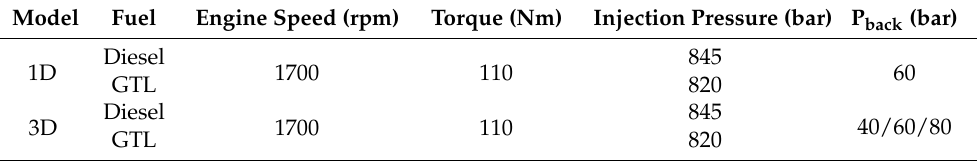
Table 3. Operating modes used in numerical